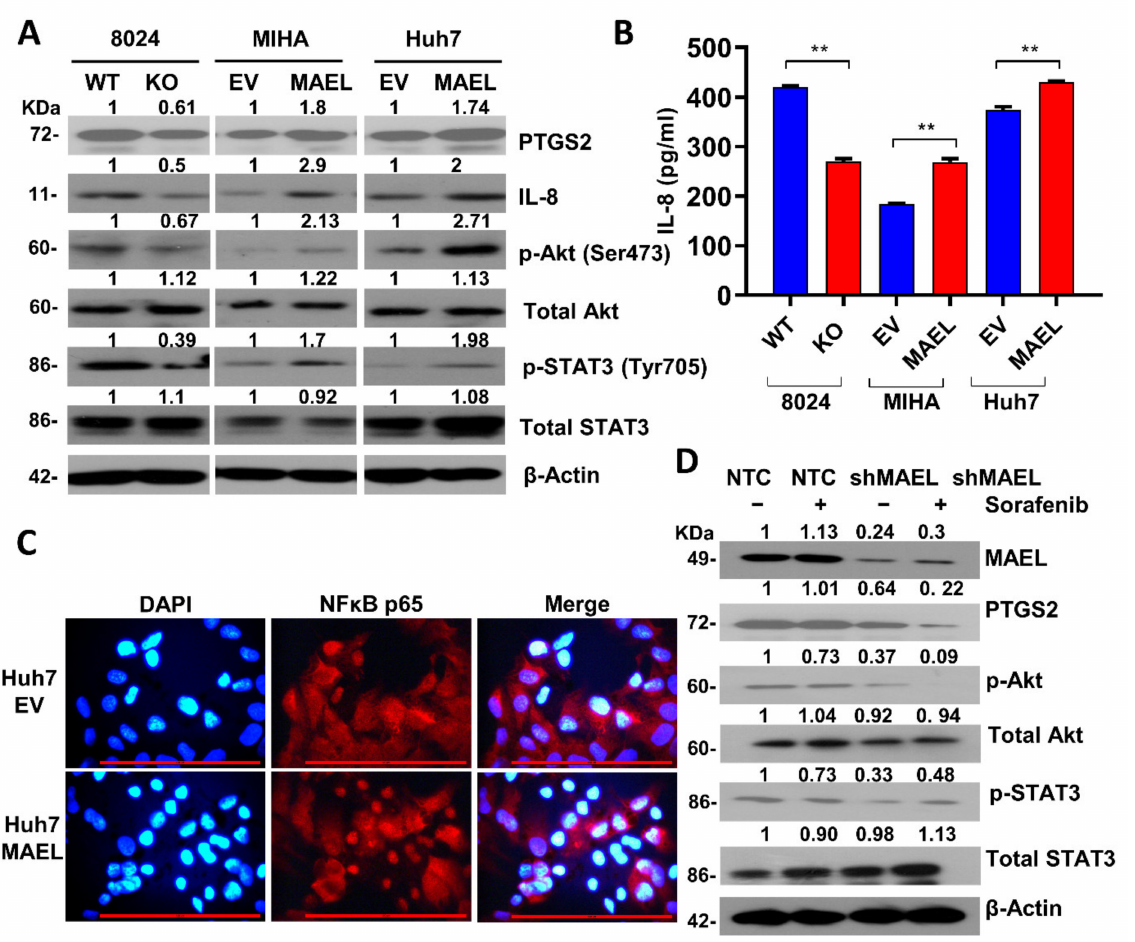
Figure 7. MAEL activates the IL8/Akt//NF κ B/STAT3 signaling pathway. ( A ) Immunoblots of PTGS2, IL-8, STAT3, p-STAT3, AKT, and p-Akt in cells with or without modulated MAEL expression. Full Western Blot can be found in Figure S9. ( B ) Quantitative analysis of IL-8 concentration determined by ELISA in MAEL expression-modulated cells. ( C ) Representative images of immunofluorescence of Huh7 cells transfected with MAEL or vector cells. Cells were stained with NF- κ B (P65) antibody (red). Nuclei were labeled by DAPI (blue). Scale bar stands for 50 µ m. ( D ) Immunoblots of pAkt, pSTAT3, and PTGS2 in PLC8024 cells treated with sorafenib with or without MAEL silencing. Data represent the mean ± SD of three independent experiments. ** p < 0.01. Full Western Blot can be found in Figure